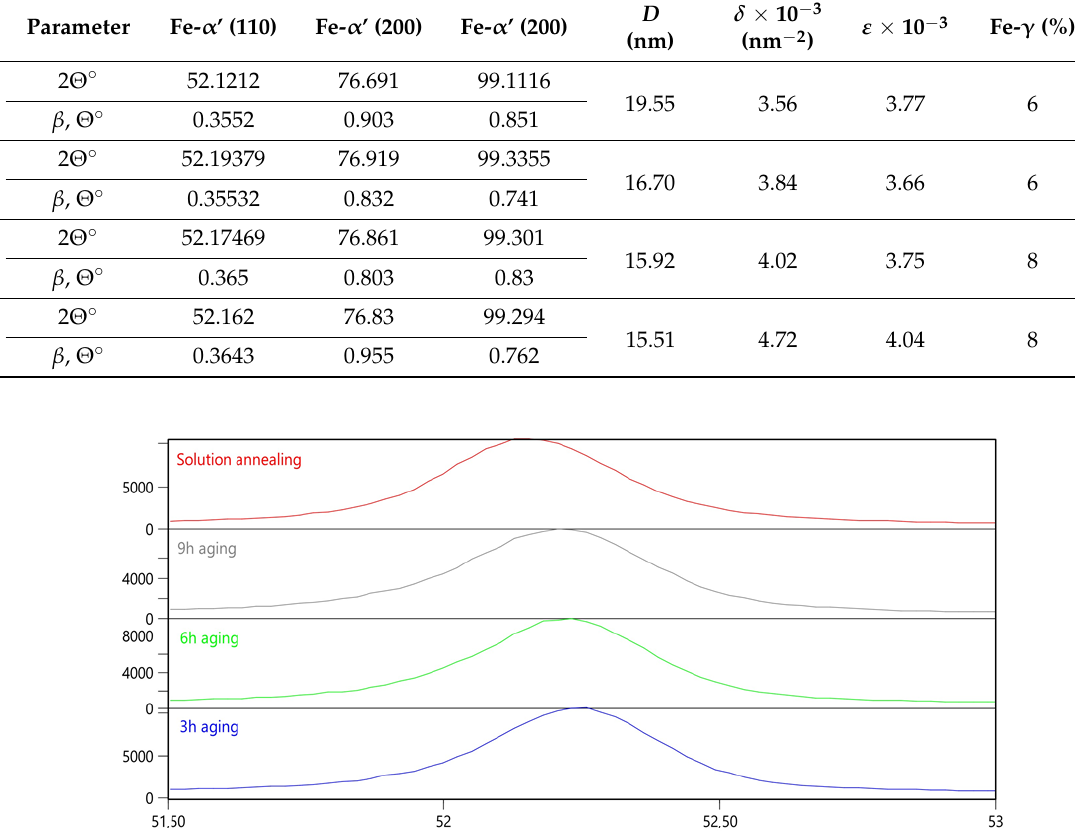
Figure 7. X-ray diffraction patterns near the Fe- α ’ (110) peak location.